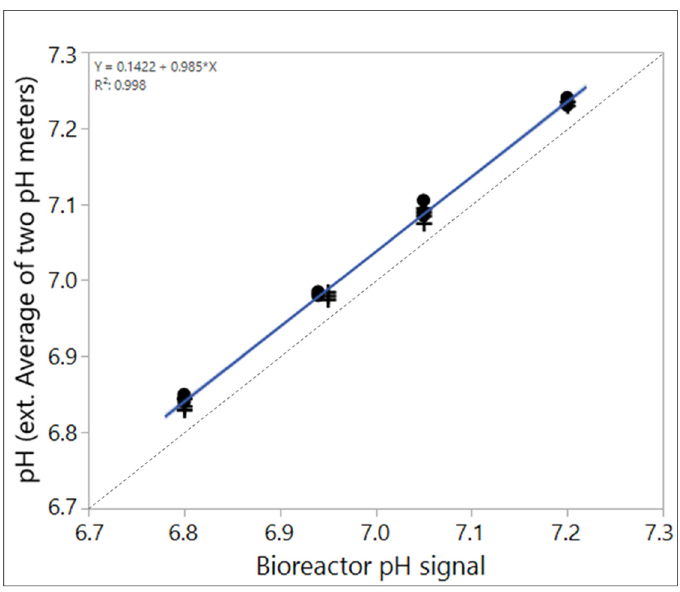
Figure 3. Average of sample-based offline values of two pH-meters compared to the bioreactor pH signal that reflects the true pH in the case shown in Figure 2. Clearly, an offset is detectable that averages around 0.04 pH in this case.